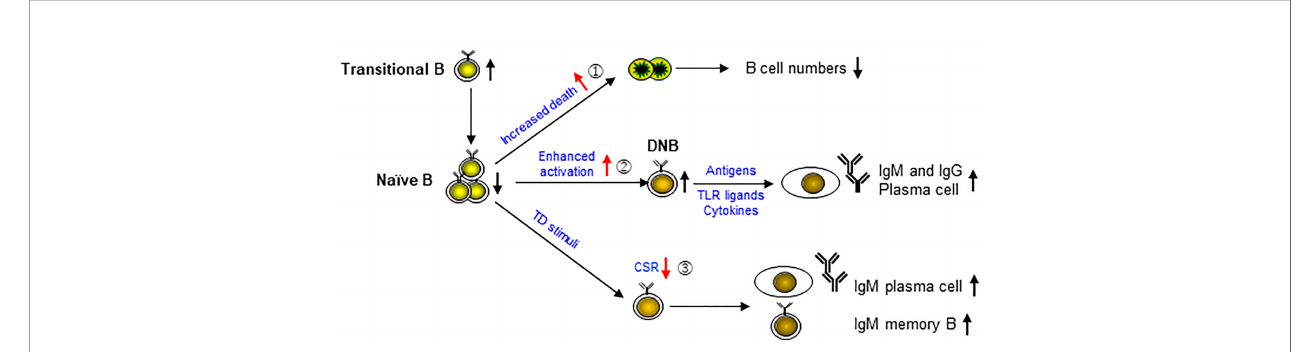
FIGURE 7 | A model for cellular mechanisms underlying the complex B cell phenotypes in APDS patients. PIK3CD GOF has been shown to cause the accumulation of transitional B cells and a reduction of naïve B cells. Our data indicate that naïve B cells are prone to die upon stimulation ( ① ), leading to progressive B cell lymphopenia. In addition, naïve B cells are in an activated state ( ② ), which may result in the generation of DNB cells that can further differentiate into IgM- or IgG- secreting plasma cells upon stimulation. Moreover, upon TD stimuli, activated B cells are impaired in CSR ( ③ ) but show relatively normal plasma cell differentiation, resulting in the generation of IgM-secreting plasma cells and possibly of IgM + memory B